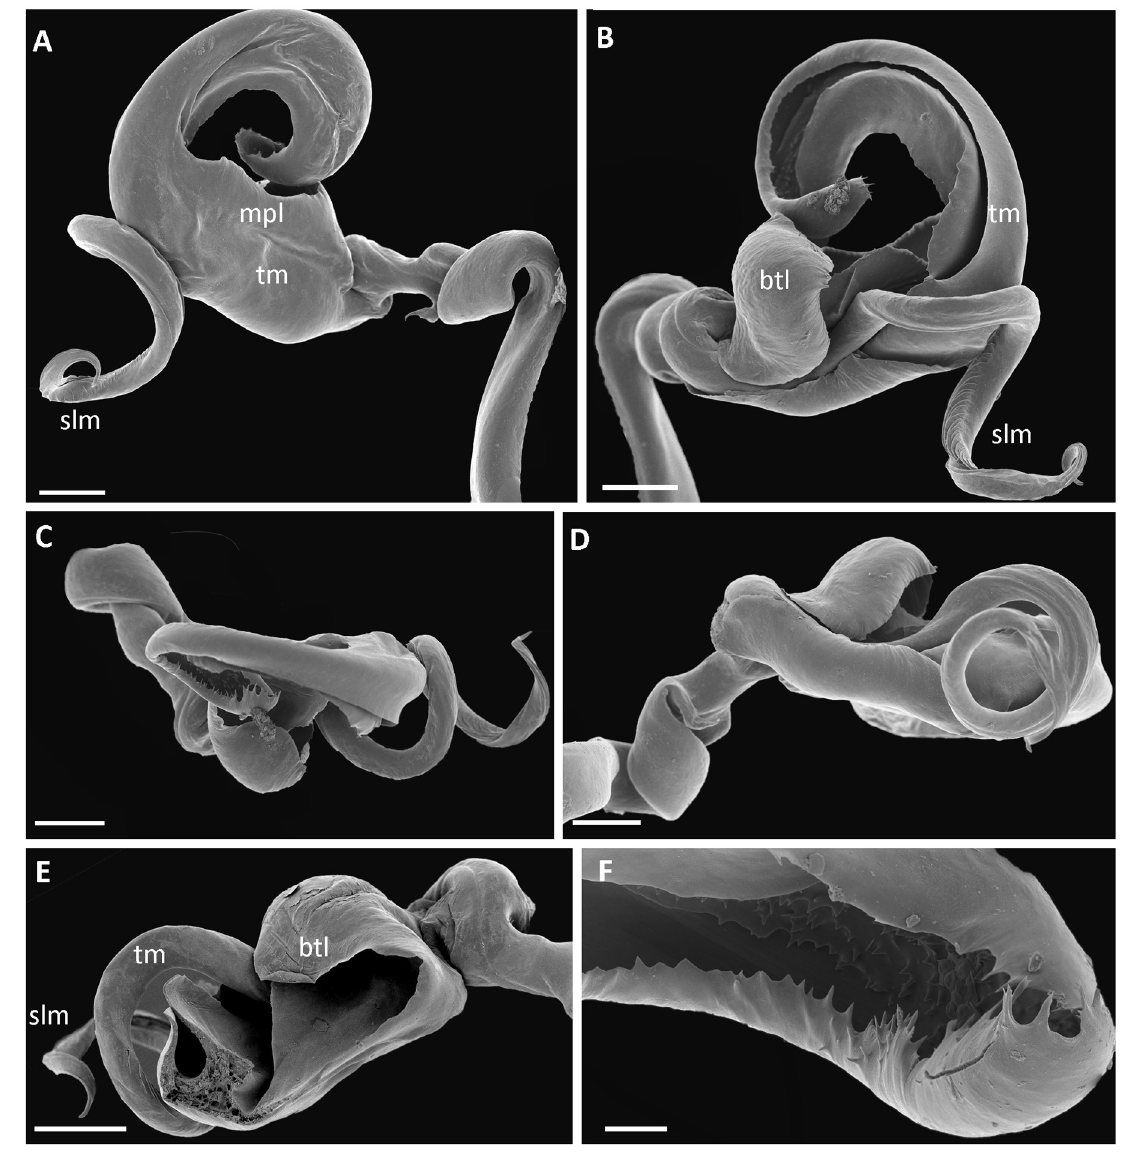
Fig.16. Aquattuor submajor Enghoff, 2015 . A – D . Male from Udzungwa Mts National Park, Kidatu (NHMD 621653), left gonopod telopodite. A . Posterior view. B . Anterior view. C . Distal (ventral) view. D . Basal (dorsal) view. E – F . Male from Udzungwa Mts National Park, Kidatu (NHMD 621654), right gonopod telopodite, broken into two pieces. E . Basal part. F . Tip of telomere. Abbreviations: btl = basal telomeral lamella; mpl = meso-posterior telomeral lamella; slm = solenomere; tm = telomere. Scale bars: A–E = 0.1 mm; F = 0.02